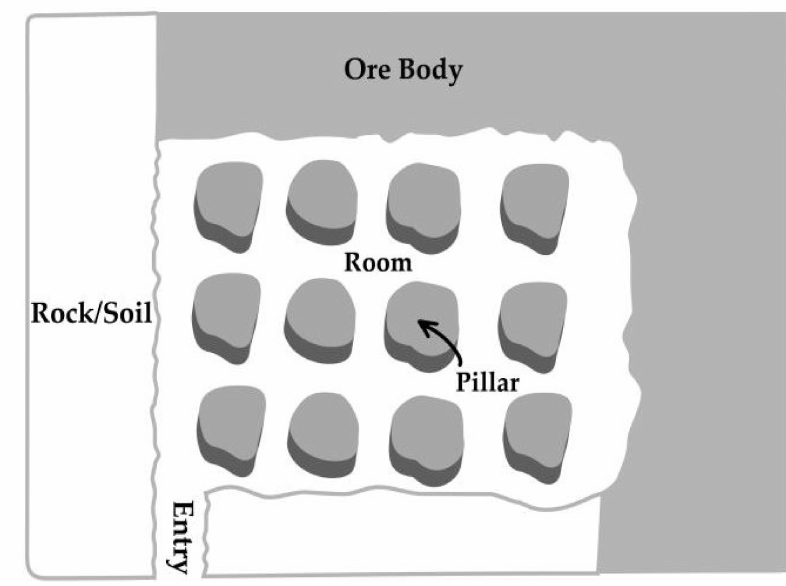
Figure 1. Room-and-pillar architecture of coal